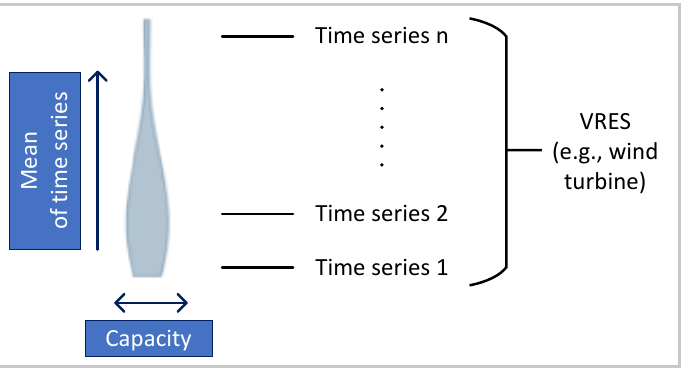
Figure 6. An example capacity distribution